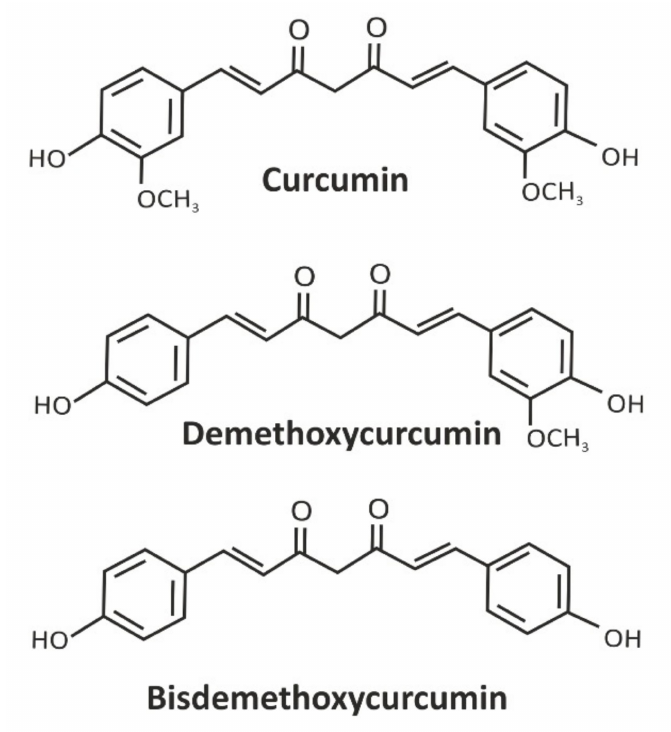
Figure 13. Major metabolites of Curcuma longa